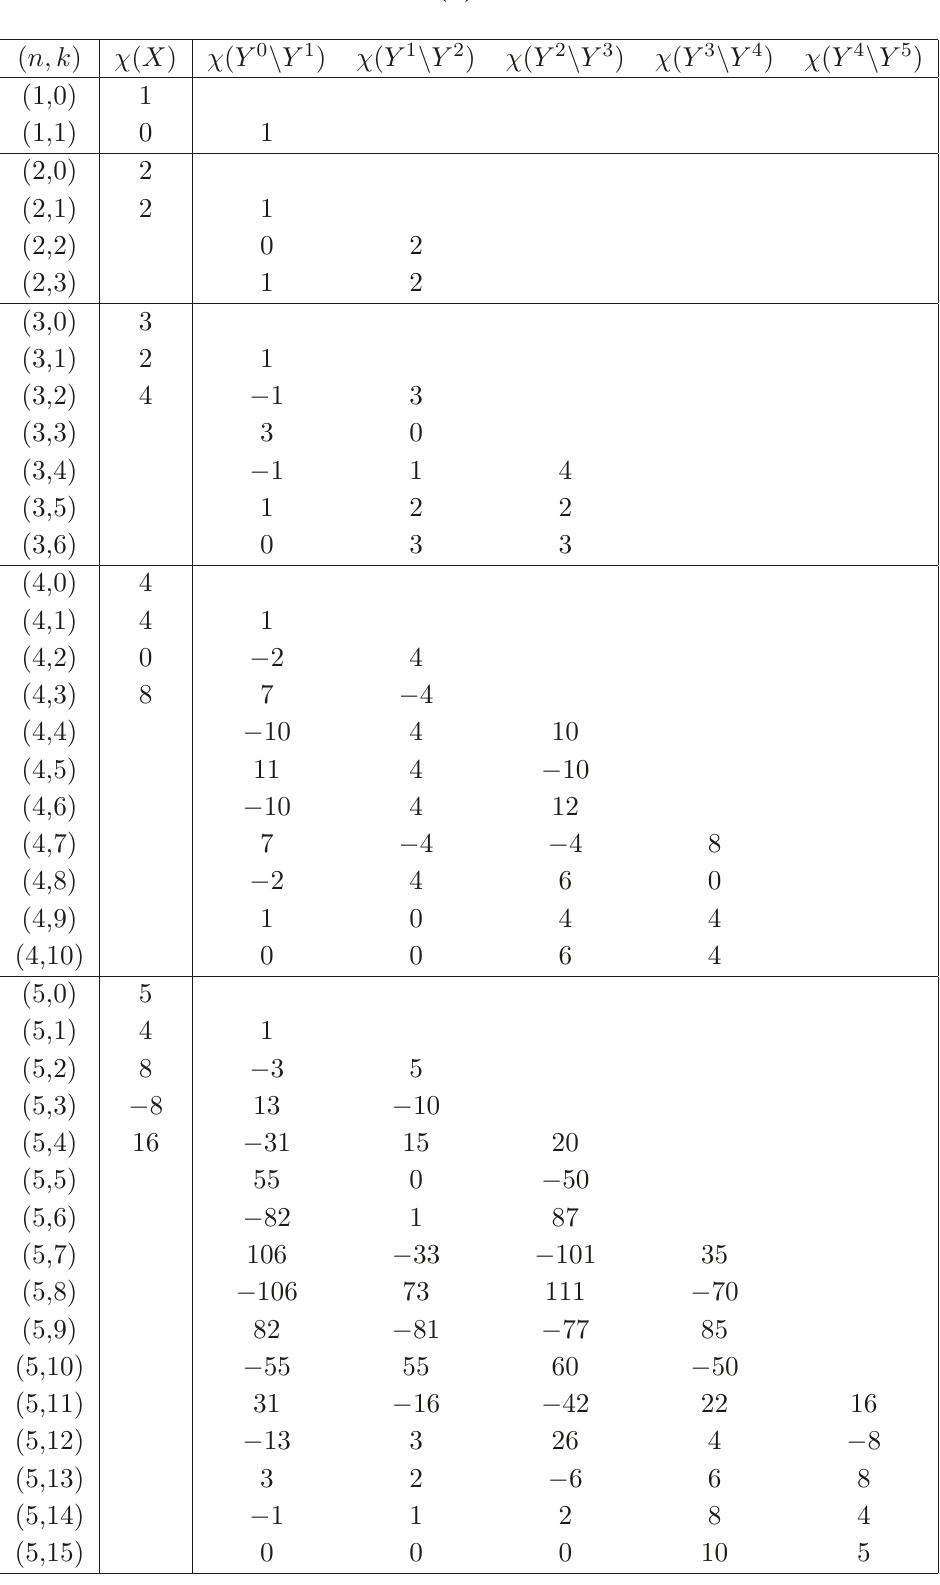
Table of Euler characteristics: the U(1)